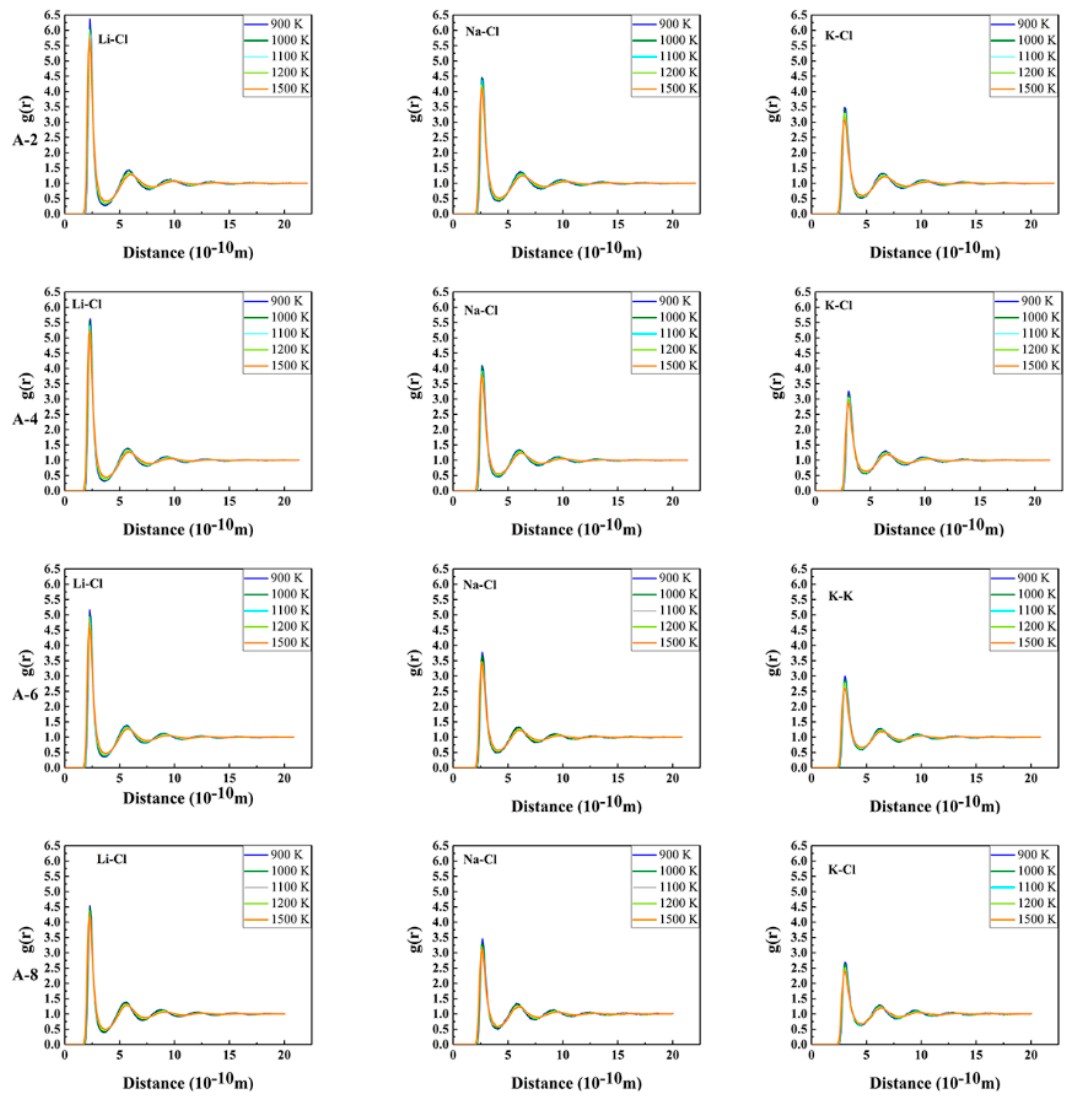
Figure A3. PDFs of unlike charge pairs in the four ternary systems (A-2, A-4, A-6, and A-8) at 900 K, 1000 K, 1100 K, 1200 K, and 1500 K.